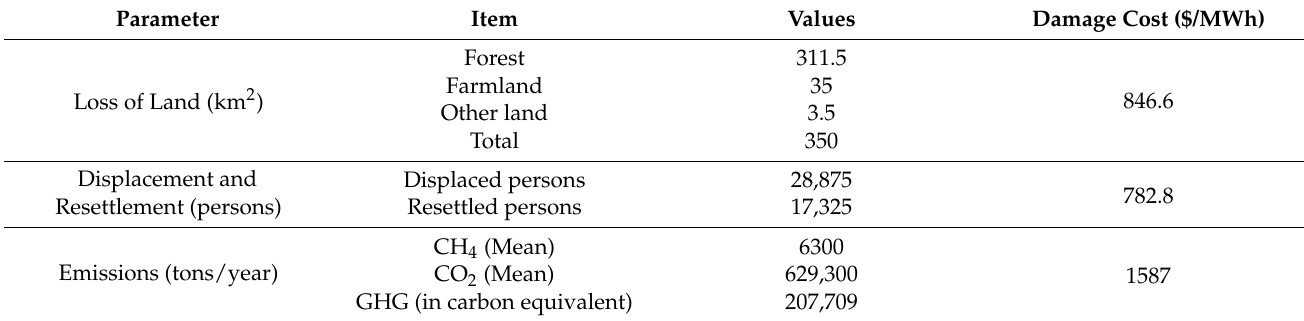
Table 6. SIMPACTS results showing the physical impacts and damage cost from Jebba hydropower plants in Nigeria. Parameter Item Values Damage Cost ($/MWh)